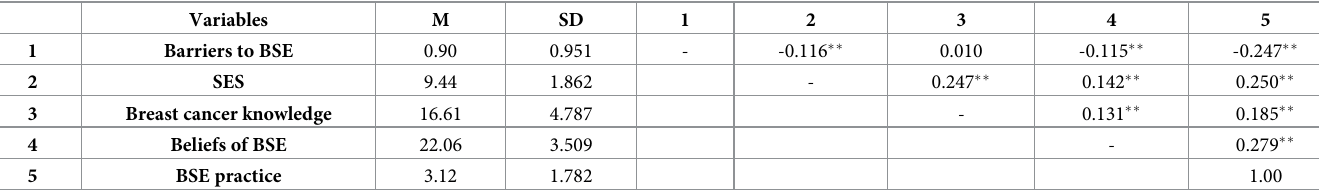
Table 2. Mean, SD, and Spearman correlation coefficients among variables (n = 2026).